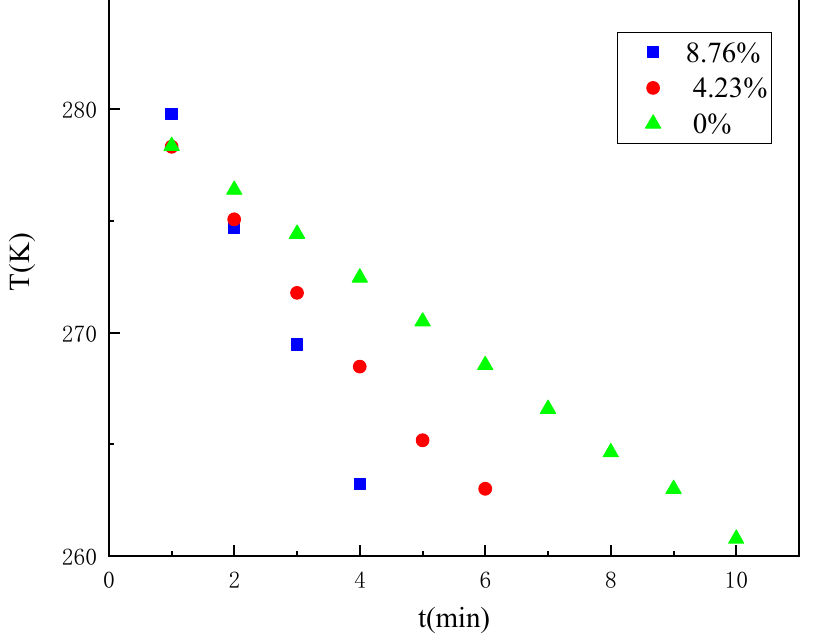
Figure 6. Temperature variation law of the coal samples with a different water content from 4 °C to − 10 °C (60 mm).